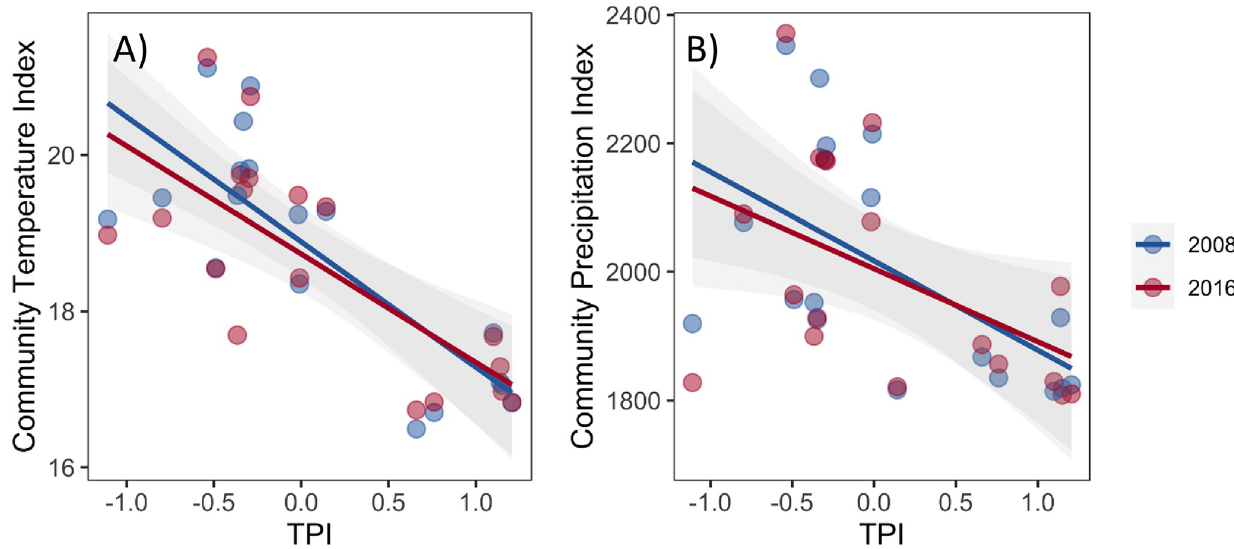
Fig 2. Scaled Community Weighted Means (CWMs) of leaf and stem functional traits as a function of topographic variation Topographic Position Index (TPI). A ll traits except for bark thickness and sapwood-specific conductivity varied significantly with TPI (S2 Table). The slopes of the linear regression lines represent the first (2008) and last (2016) sampling years were not significantly different for any trait. Each point represents a forest monitoring